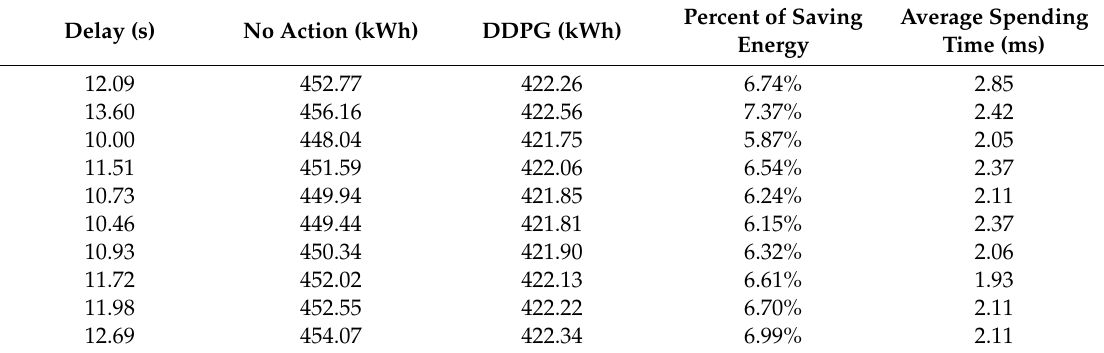
Figure 16. Energy accumulation under a 13.60 s delay in the three-train network.